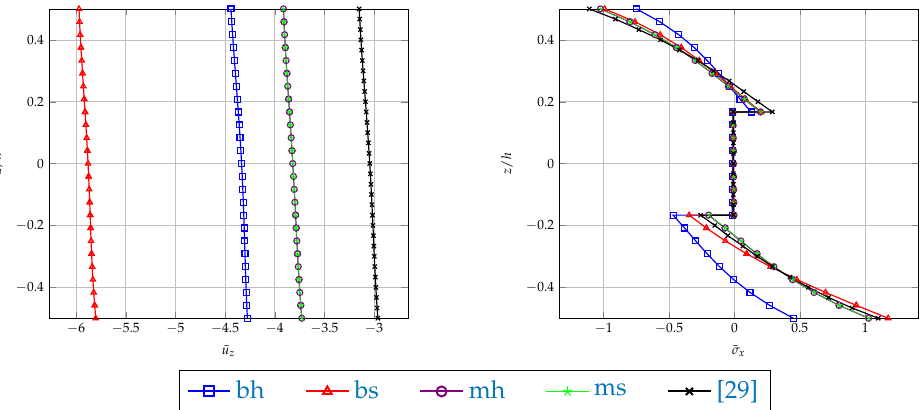
Figure 4. Example 1: Plots of dimensionless deflection ¯ u z and stress component ¯ σ x in the middle of the plate with a / h = 4, along the plate thickness calculated by FEM23 with different types of boundary